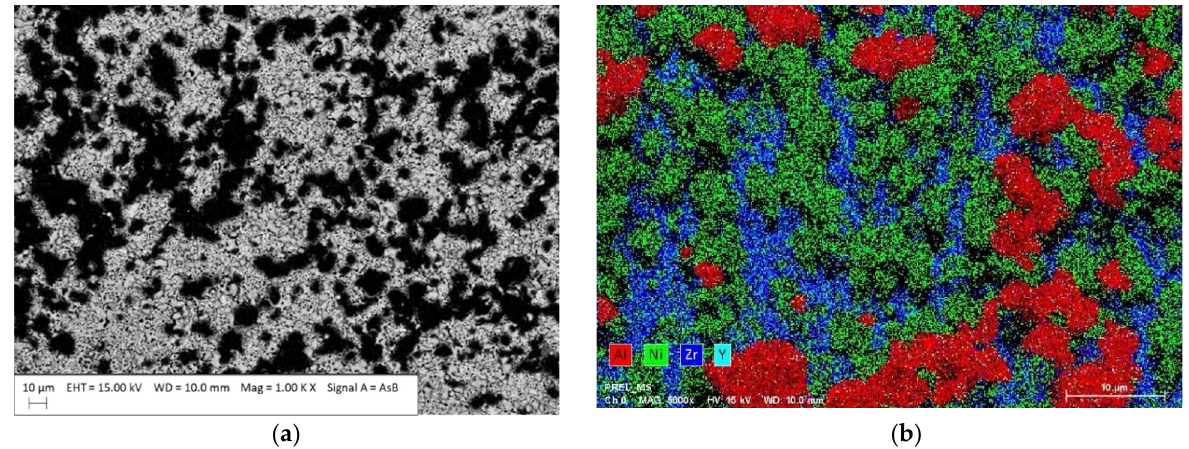
Figure 12. Analysis of the anode support surface near the gas outlet after Experiment II by ( a ) SEM image at 1000× magnification; ( b ) EDS map at 5000× magnification.